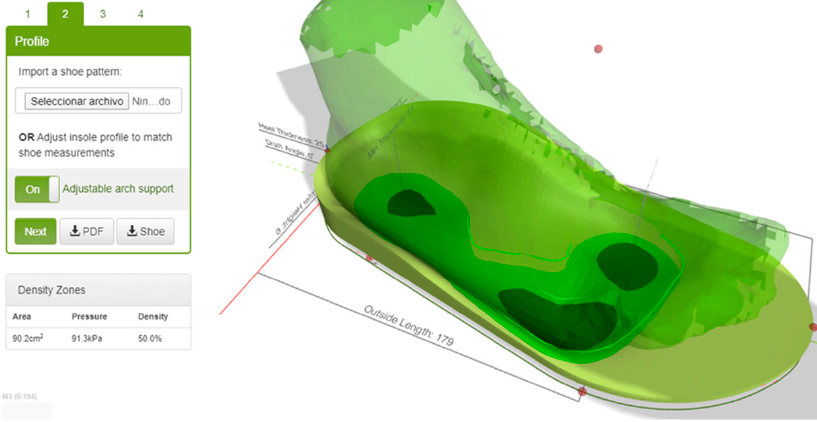
Figure A3. Insole infill.